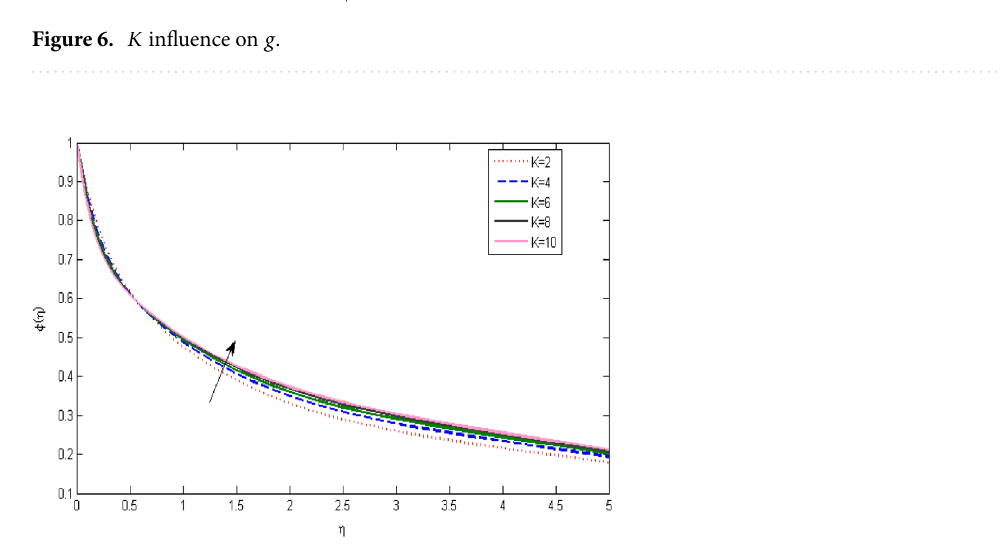
Figure 7. influence on g